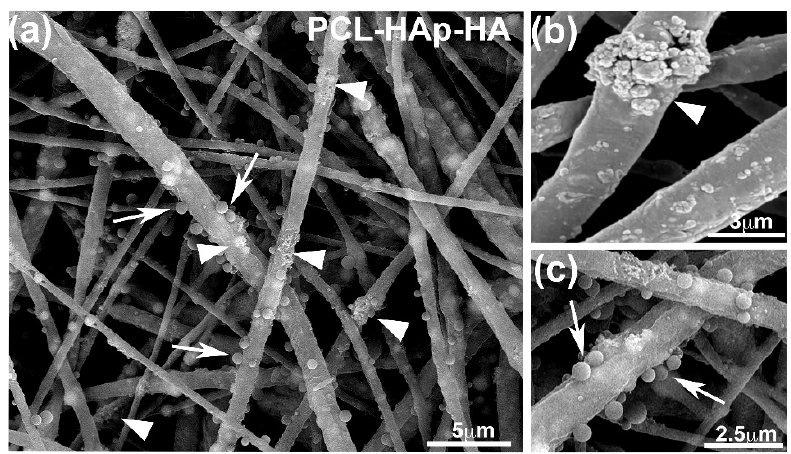
Figure 1. SEM images of polycaprolactone (PCL)-hydroxyapatite (Hap)-hyaluronic acid (HA) sca ff old. Arrowheads point to HAp in ( a , b ) and arrows point to poly(vinyl-pyrrolidone) (PVP) particles in ( a , c ).